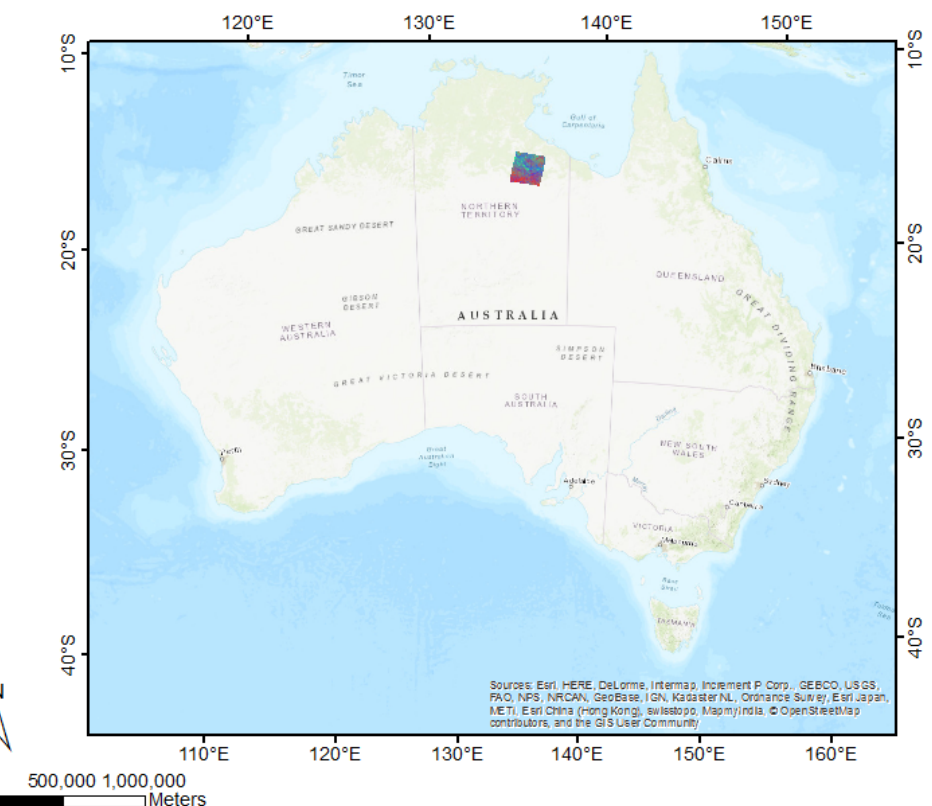
Figure 1. FCover scene in the Northern Territory showing the Landsat footprint of path 102 row 72 at the Worldwide Reference System-2 (WRS-2) and is covering an area of 185 × 185 km.